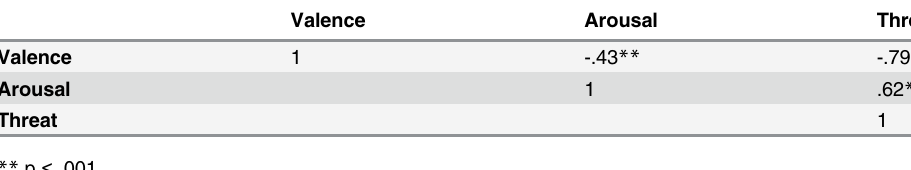
The Pearson ’ s zero-order correlation coefficients between the emotional words are shown in Table 6. There were significant correlations for all of the bi-dimensional relationships in the expected directions. First, valence and threat were negatively correlated (r = -.79, p. < .001), showing that words that were more pleasant were less threatening. Second, a significant nega- tive correlation was obtained between arousal and threat (r = .62, p < .001), i.e. words that were more threatening tended to arouse more excitement among the participants. Finally, a negative linear relationship was obtained between valence and arousal (r = -.43, p < .001), sug- gesting that words that were more negative tended to elicit more excitement. Bradley and Lang [7] and other studies of affective word adaptation in different languages, such as Spanish [13], European Portuguese [17], and Finnish [12] have reported a quadratic relationship between valence and arousal. This quadratic relationship was thus examined in the current study.A U-shaped distribution (R = .72, p < .000), indicating that very positive or Table 6. Correlations between the